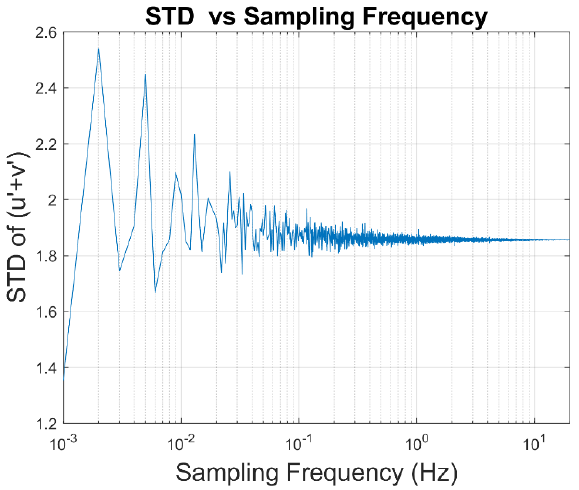
Figure 2. Stand deviation of ( u (cid:48) + v (cid:48) ) , as a function of sampling frequency for an arbitrary 30-min run.